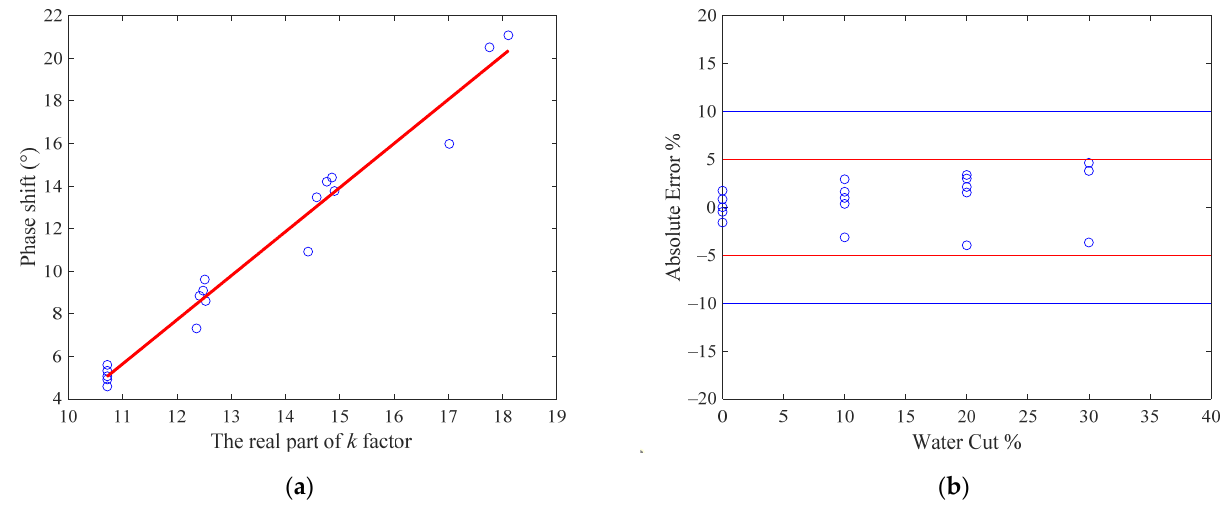
Figure 8. The fitting results of the phase shift and the measurement errors of the water cut under oil-continuous flow conditions: ( a ) the fitting results of the phase shift; ( b ) the measurement error of the water cut. The red lines denote the ± 5 % error range and the blue lines denote the ± 10 % error range.